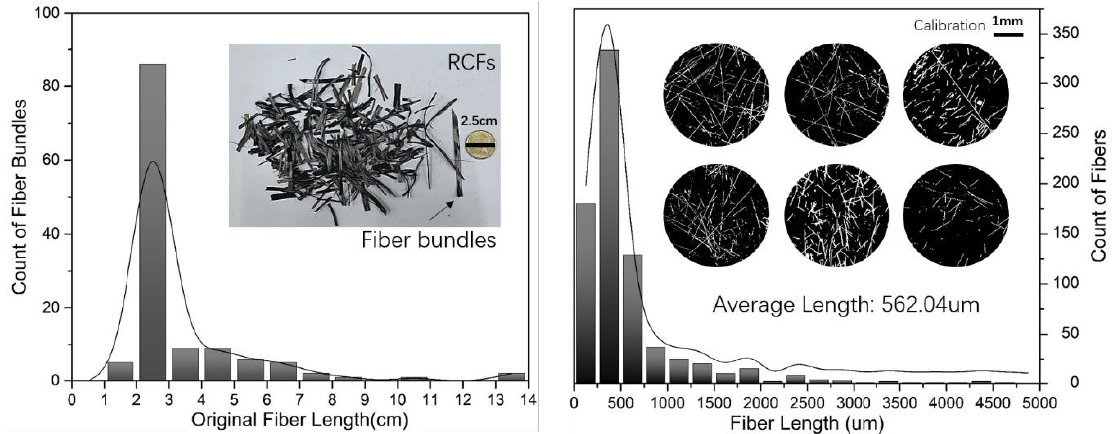
Figure 14. Comparison of fiber length before and after processing.